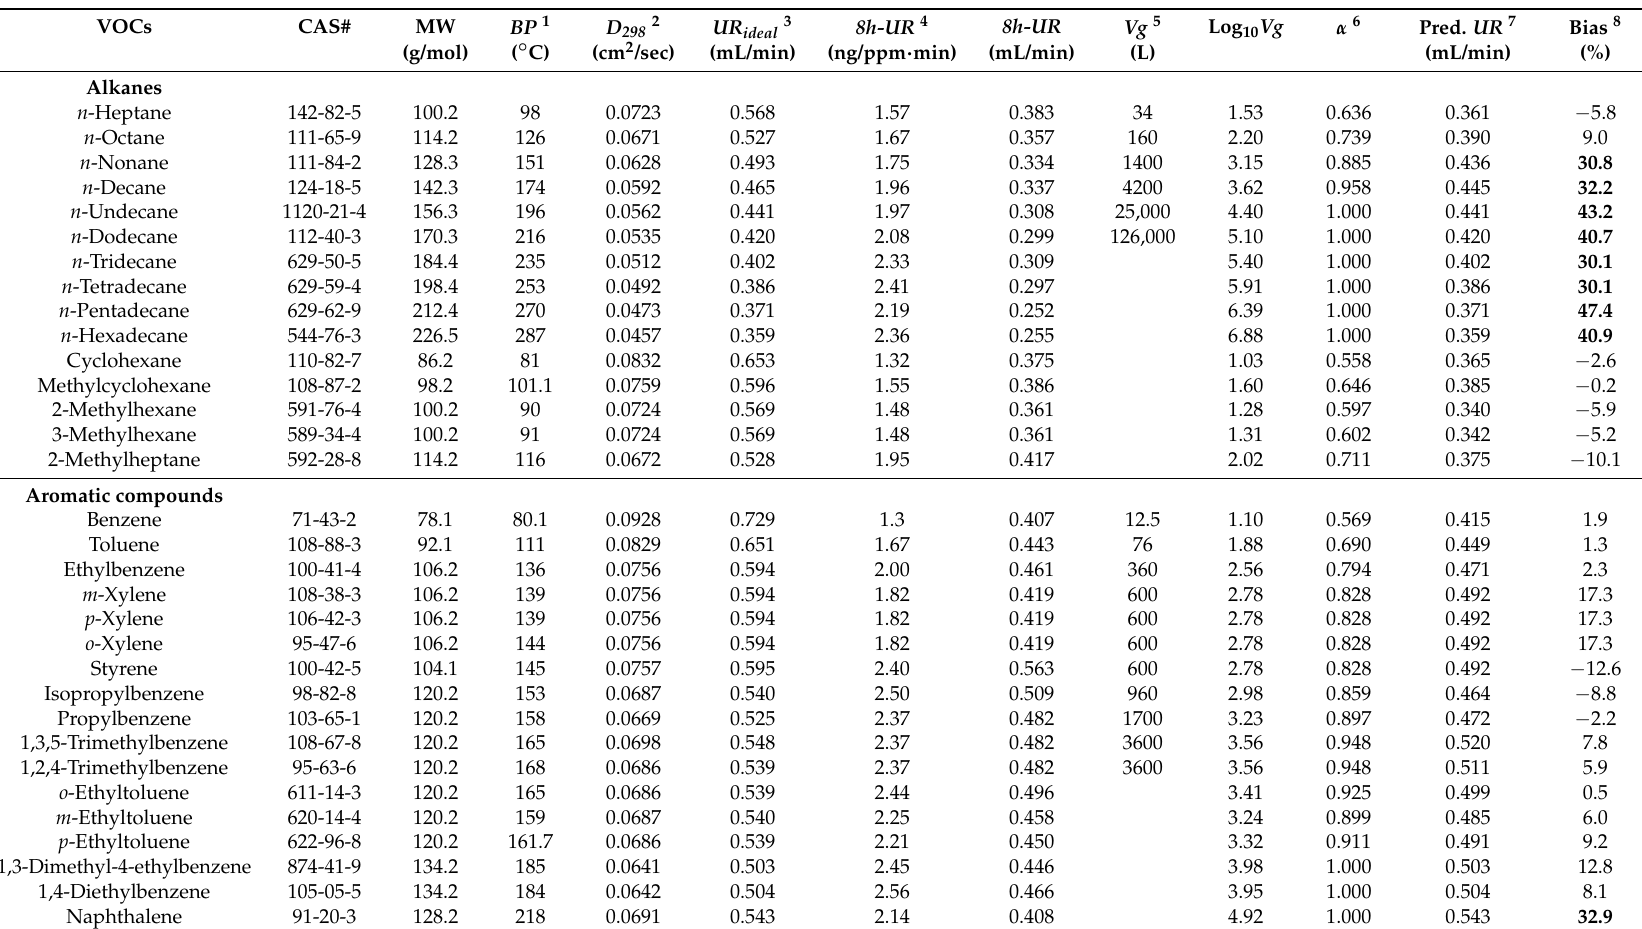
Table A1. Physical and chemical properties, diffusion parameters, measured and modeled uptake rates of volatile organic compounds measured in